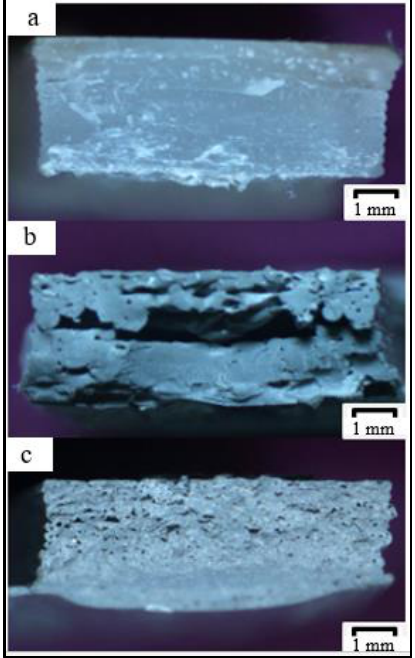
Figure 13. Impact test specimen fracture: ( a ) PP ; ( b ) rPP ; ( c ) rPP + 10%.